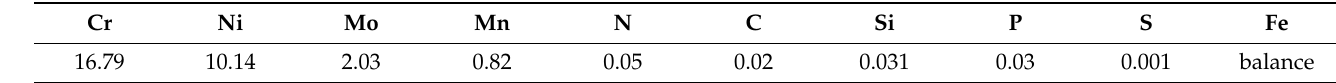
Table 1. Chemical composition of AISI 316L stainless steel